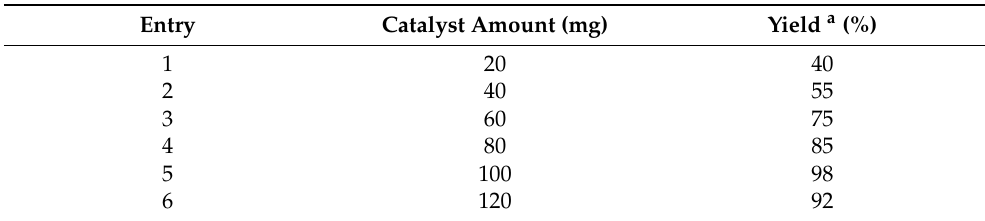
Table 3. Effect of 50% Al 2 O 3 catalyst loading for the synthesis of the model compound under optimized conditions under solar heat.